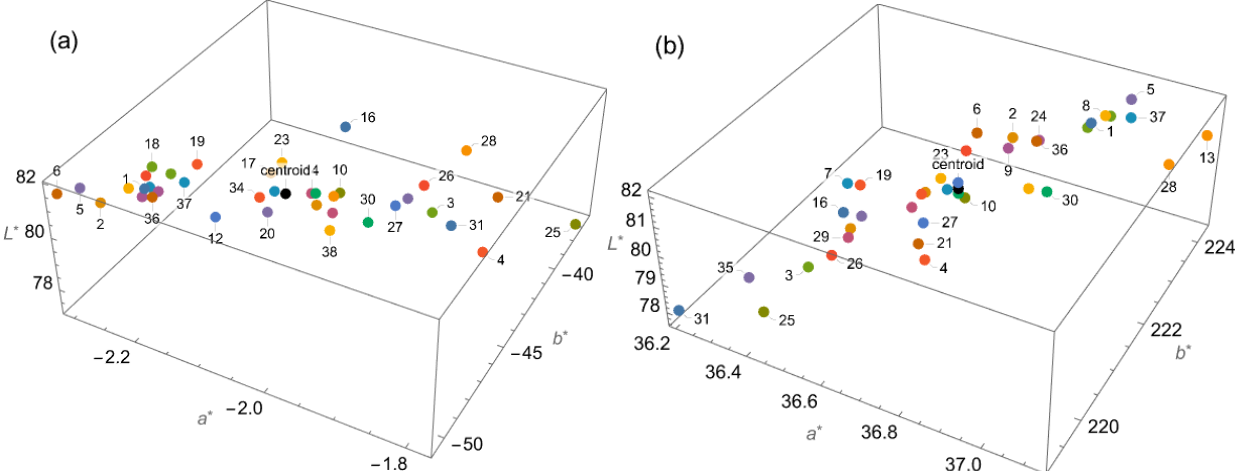
Figure 7. CIE L*a*b* color coordinates of the AISI 430 ferritic stainless steel samples determined for the D65 illuminant ( a ) and the LED illuminant ( b ). The position of the centroid of the set of color points is marked in black. Sample IDs from Table 2 have been used in the figures.